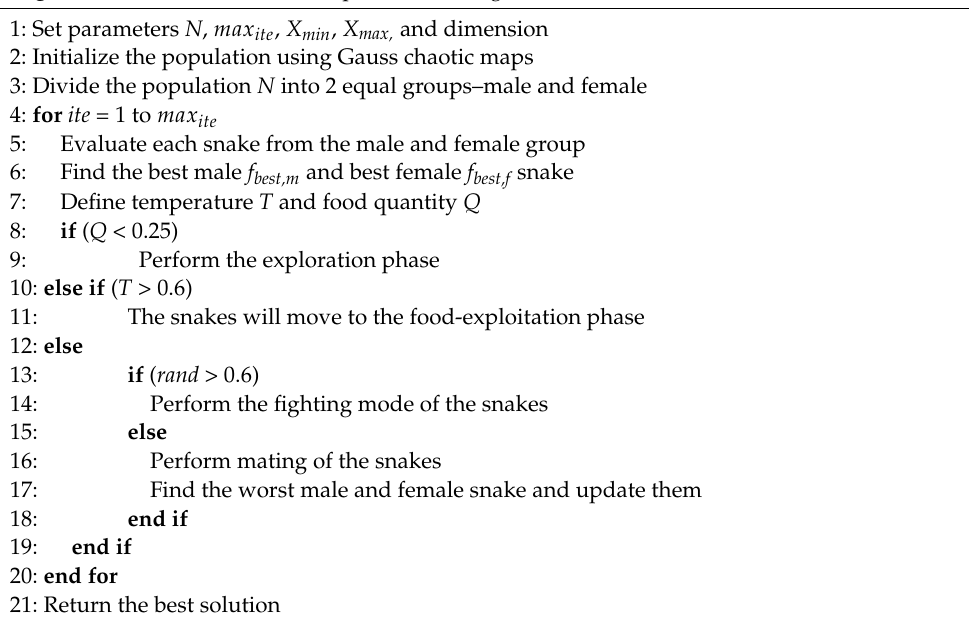
Algorithm 1 Procedure of the Proposed C-SO